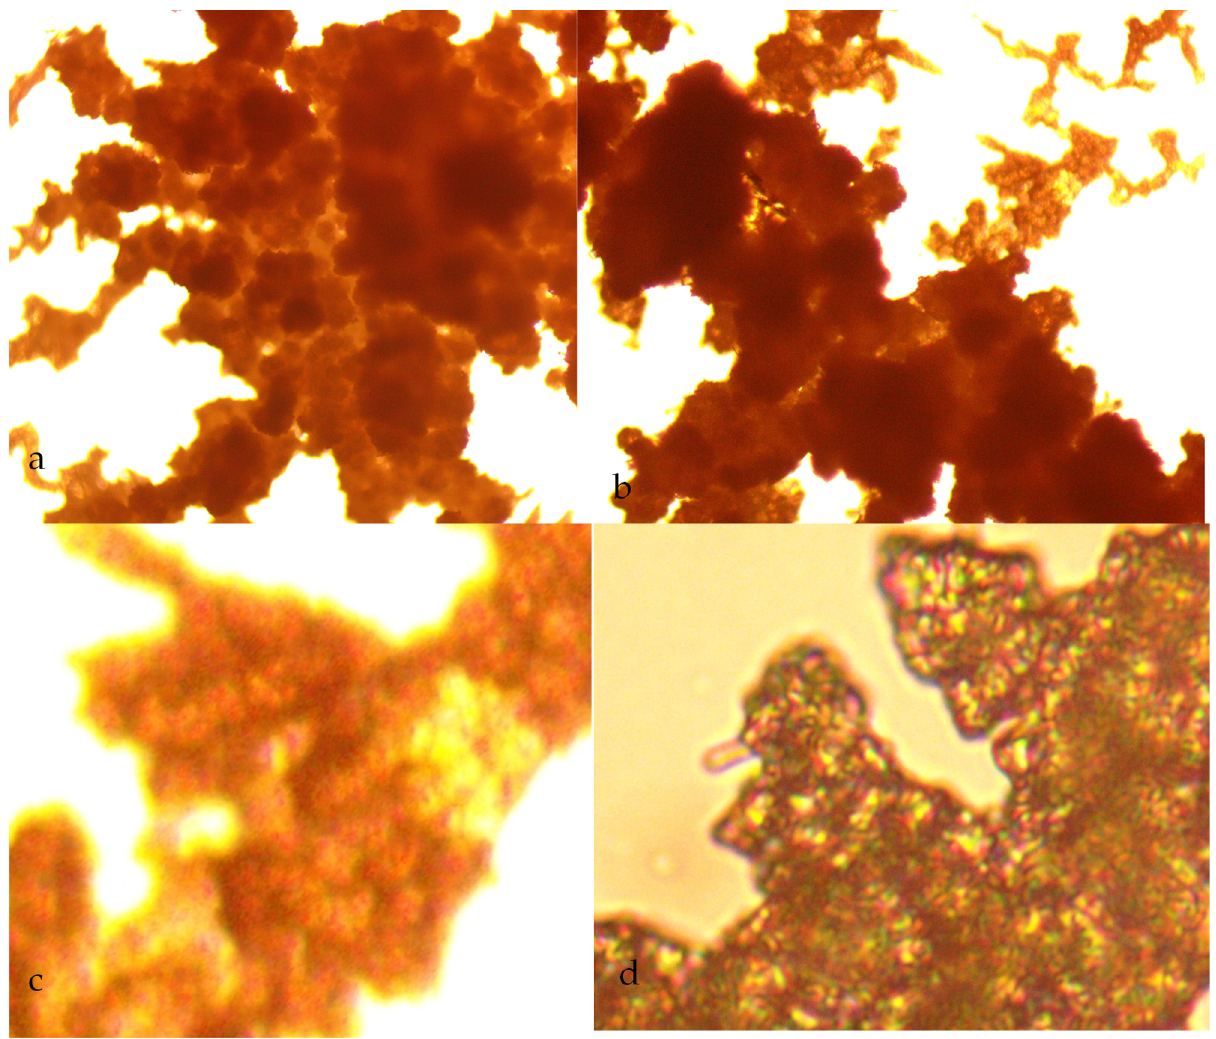
Figure 6. n-Fe(b)@Ca@Mn polymer (0.2 g Fe L − 1 ). Feed water (seawater): Cl − = 26.55 g L − 1 ; Na + = 17.21 g L − 1 ; pH = 8.31; Eh = 0.372 V; PSE = 0.0447 V; Product water = Cl − = 9.64 g L − 1 ; Na + = 2.50 g L − 1 ; pH = 12.54; Eh = − 0.098 V; PSE = − 0.0078 V; Desalination period: 241 h. Tempera-